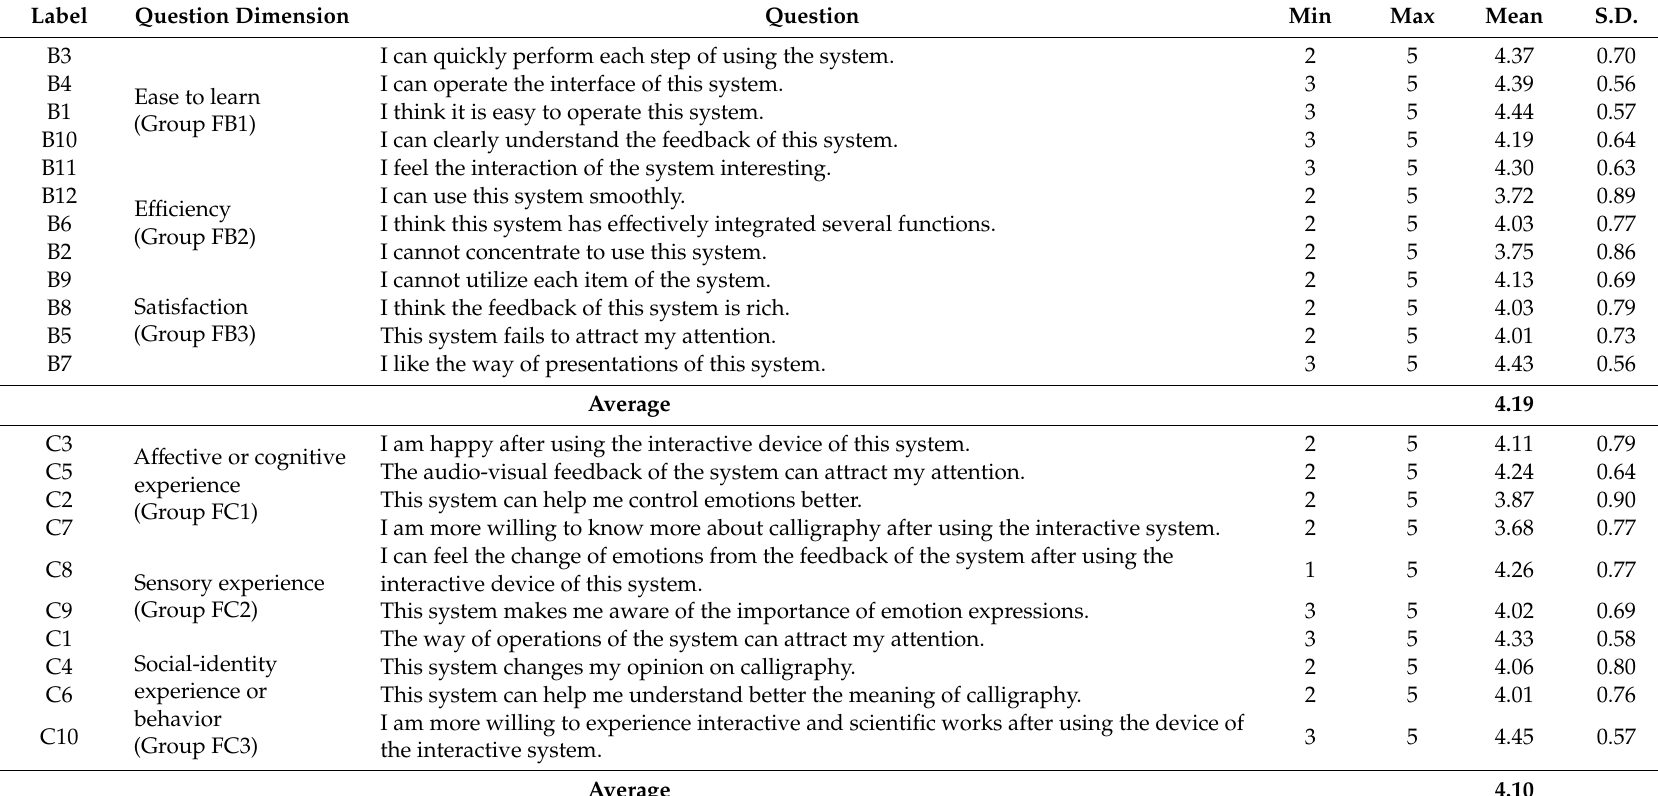
Table 14. The question dimensions (scales) of the questions of the two indicators of system usability and writer’ experience by exploratory factor analysis using the